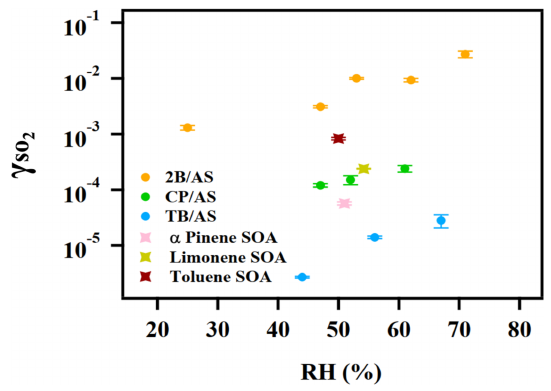
Figure 7. Predicted γ SO using Eq. (13) versus measured γ SO 2 ammonium sulfate or malonic acid aerosol containing 2-butanone peroxide (2B), cumene hydroperoxide (CP), and tert-butyl hy- droperoxide (TB) under different experimental